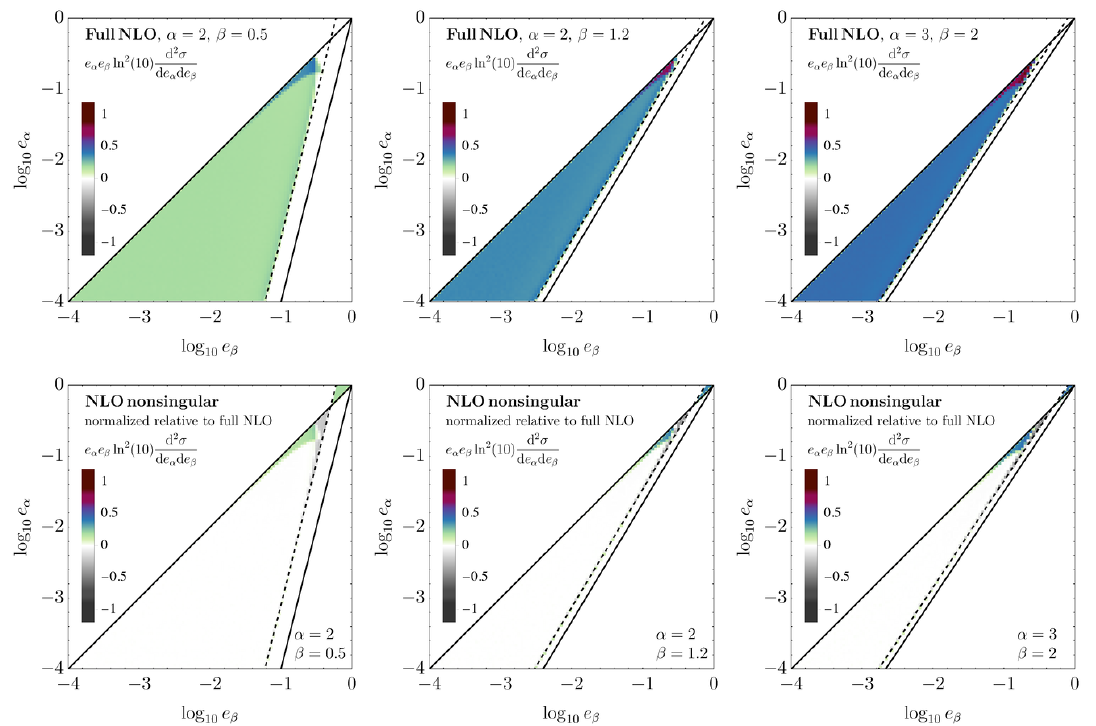
Figure 3 . The full NLO and NLO nonsingular cross sections, for three pairs of angularities ( (cid:11); (cid:12) ) = (2 ; 0 : 5) ; (2 ; 1 : 2) and (3 ;